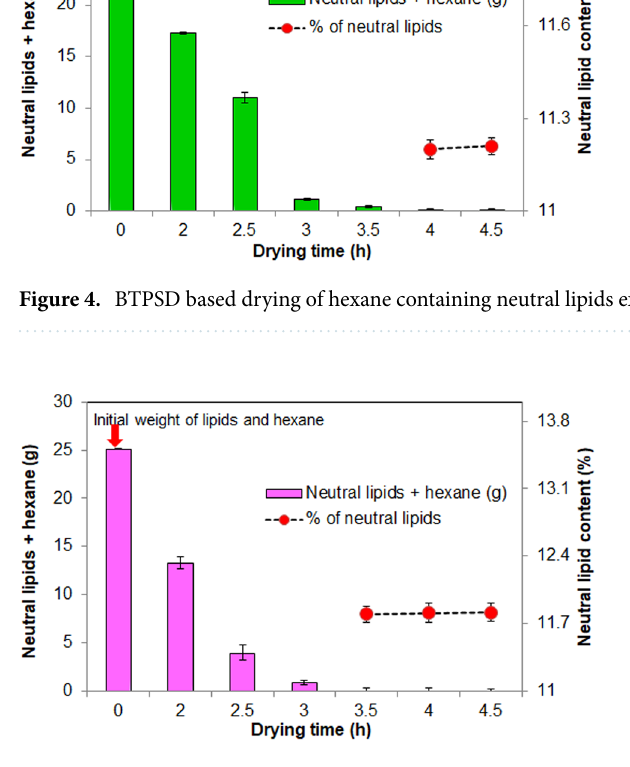
Figure 5. Hot air oven based drying of hexane containing neutral lipids extracted from C. vulgaris